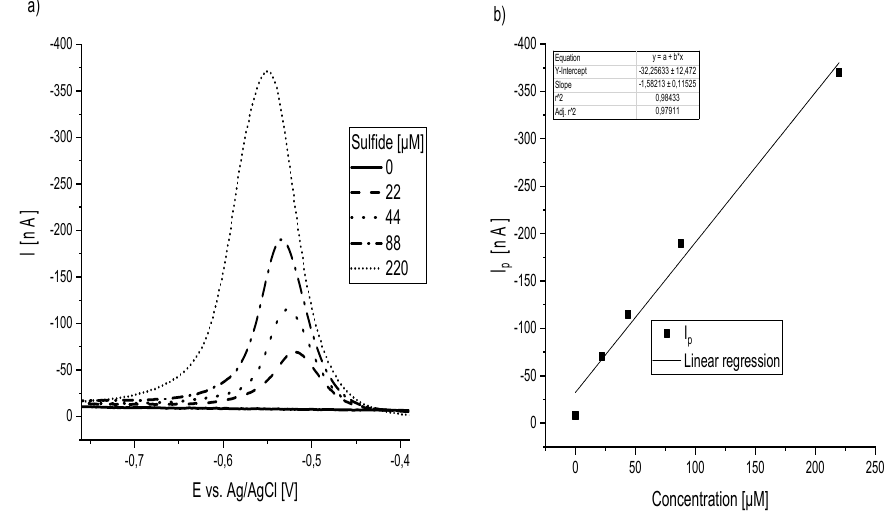
Figure 3. ( a ) Voltammograms of cathodic stripping during GAME calibration and ( b ) respective sulfide calibration curve in type 1 artificial wastewater (AWW 1) at room temperature.